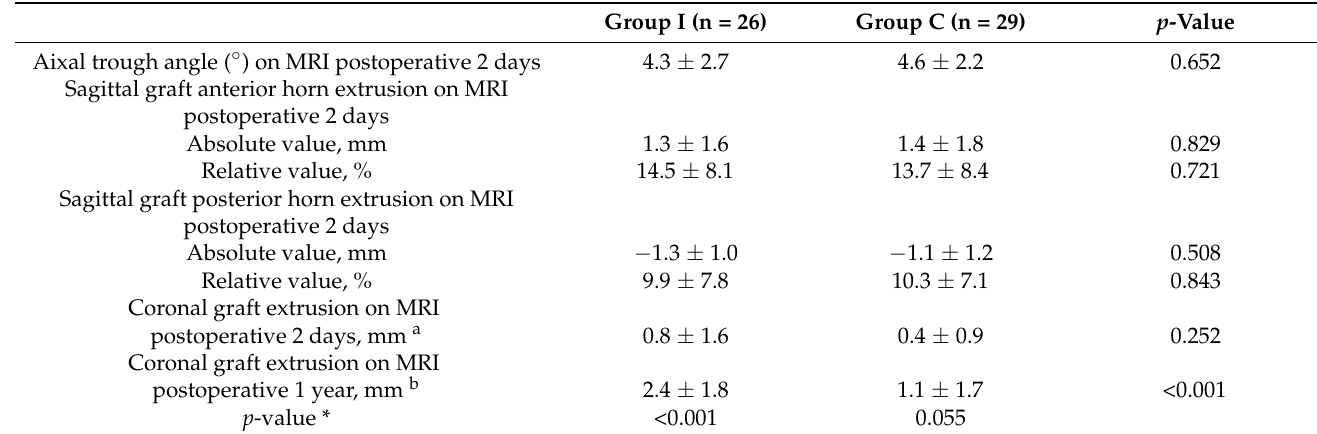
Table 2. Graft extrusion.